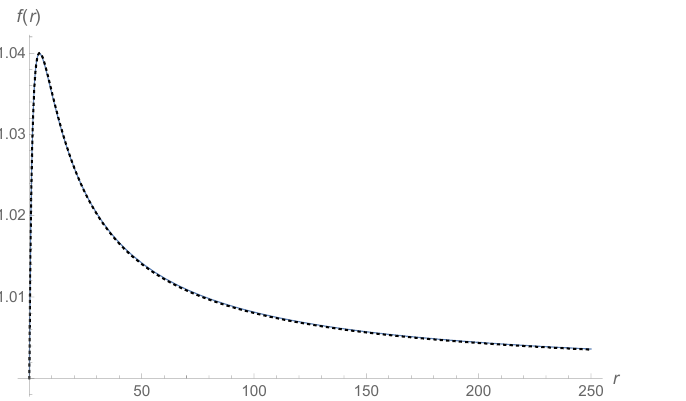
Figure 6 . Log-log plot of the numerical solution for the interpolating function f with A = 1.